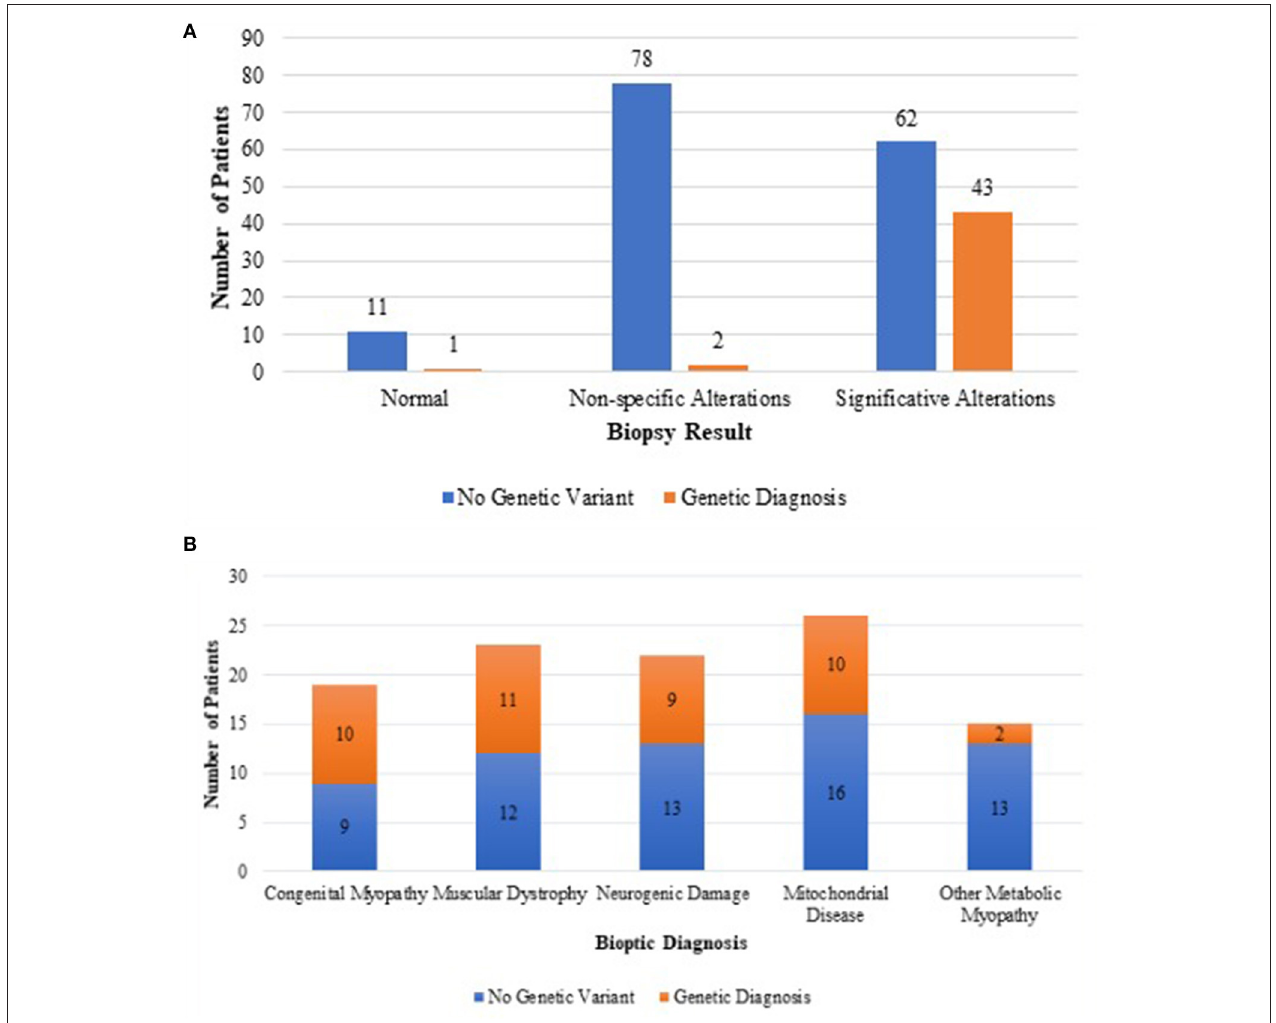
FIGURE 2 | Difference in genetic outcome between unspecific muscle biopsies and biopsies suggesting a definite histopathological diagnosis (A) . Genetic outcome of each category of biopsy suggesting a definite histopathological diagnosis (B)